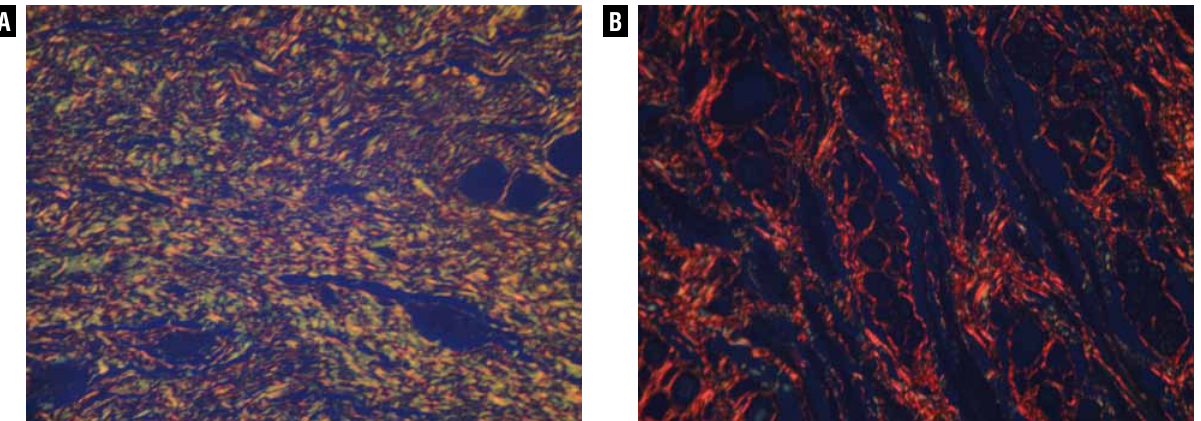
Figure 7 - A - Photomicrography of the urethra - Group I animal, postoperative day 90, Picrosirius Red staining, 25x. Green area collagen (type III). B - Photomicrography of the urethra - Group II animal, postoperative day 90, Picrosirius Red staining, 25x. Blue area collagen (type III)